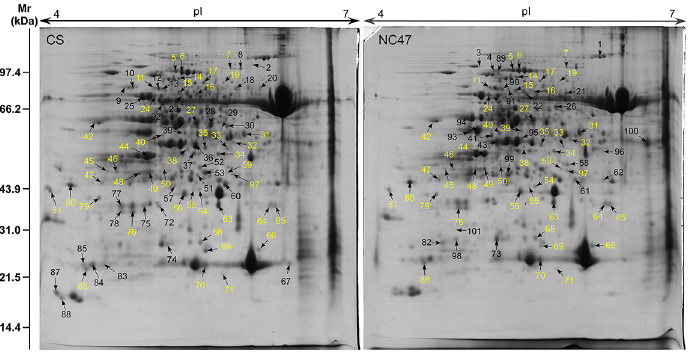
Fig 2. Proteome maps of two spring wheat varieties. (A) CS under the control condition. (B) NC47 under the control condition. The numbered protein spots were identified by MALDI-TOF/TOF, and yellow numbers represent the common DAP spots in NC47 and